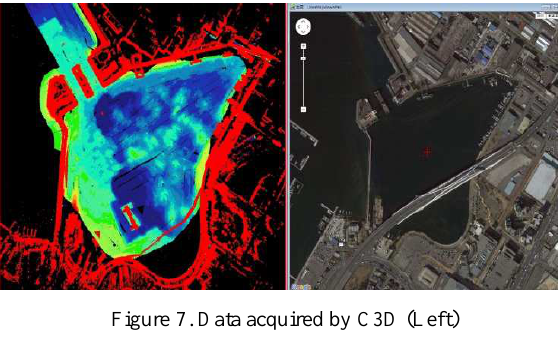
Figure 7. Data acquired by C3D (Left) & Aerial orthophoto (Right)